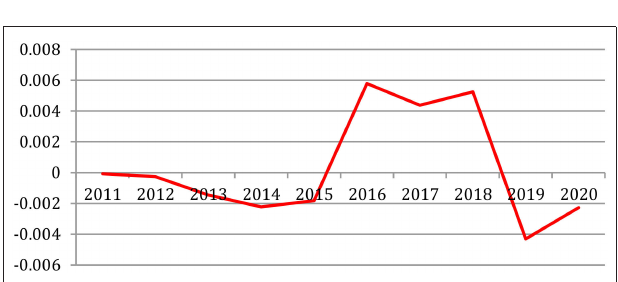
FIGURE 39 | Measure of the expectation of an emerging research topic: Deep Neural Networks (DNN).